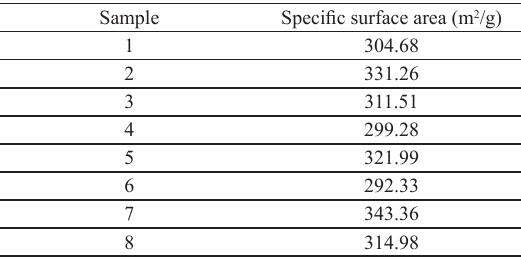
Table 5. Specific surface area of the samples. Sample